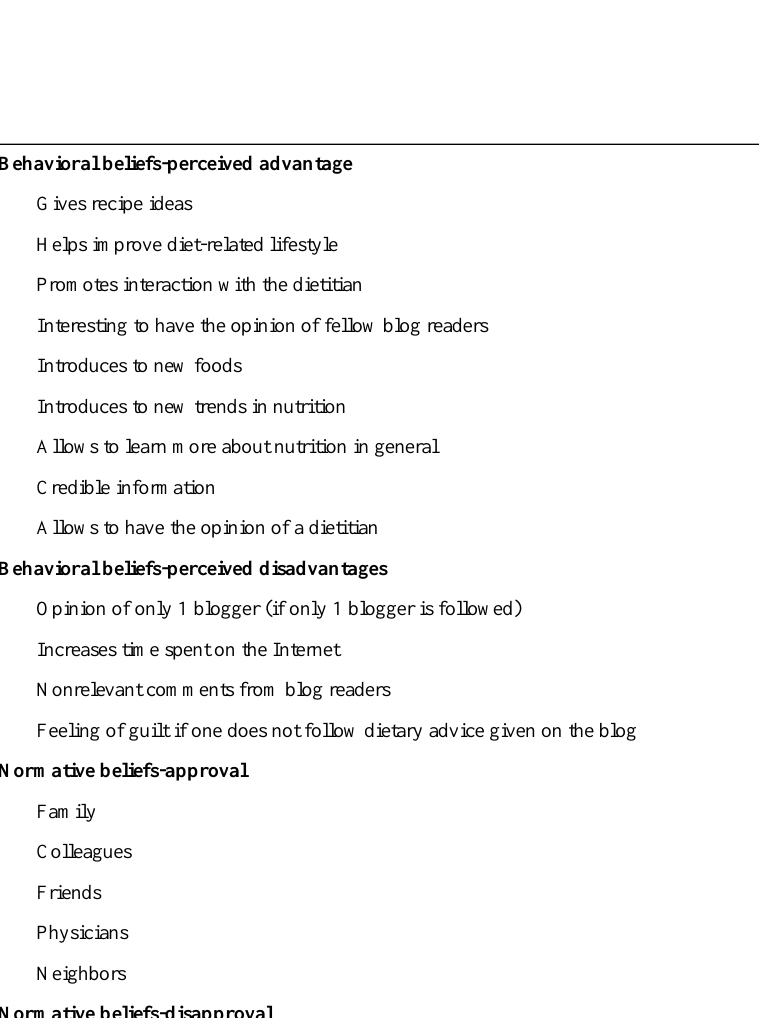
Table 3. Salient beliefs associated with the use of a healthy eating blog. (n=6)Salient